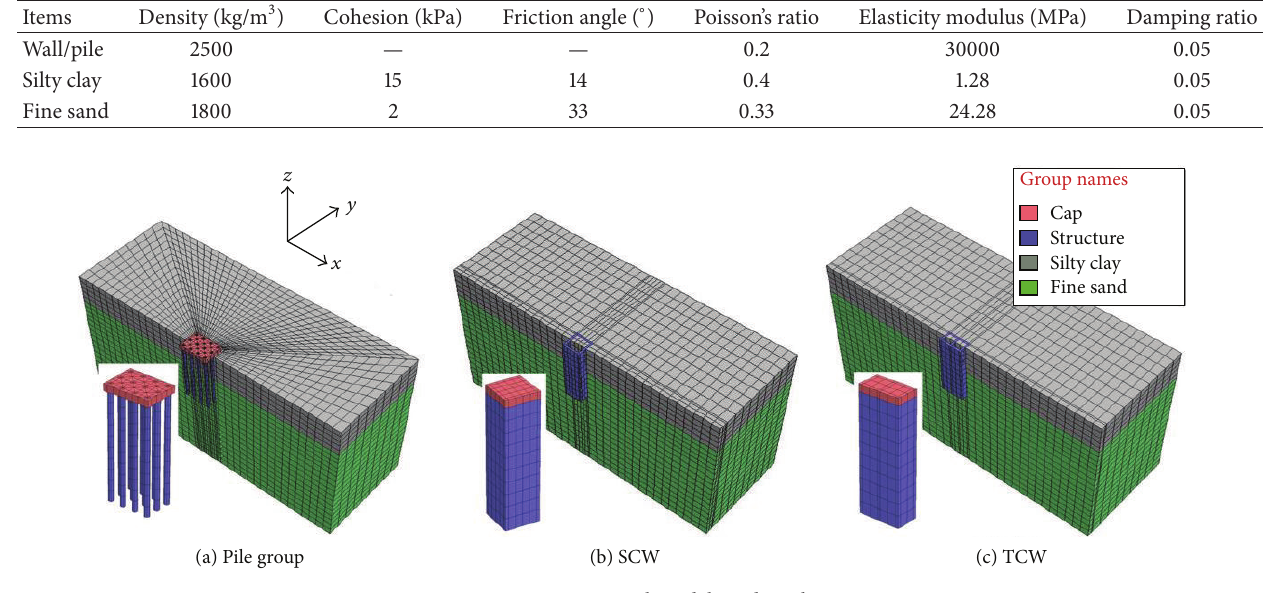
Figure 6: Numerical models and mesh.